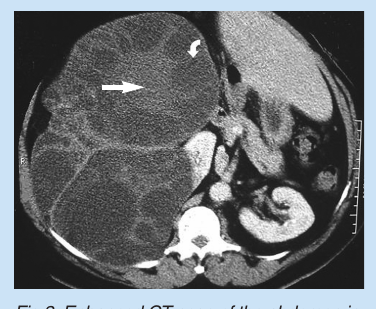
Fig.3. Enhanced CT scan of the abdomen in a different patient showing the typical ‘wheel spoke’appearance of a type II cyst in the right kidney. The daughter cysts (curved arrow) are of lower attenuation than the mother cyst and are arranged along the periphery. The mother cyst has a matrix with a density of 35 HU